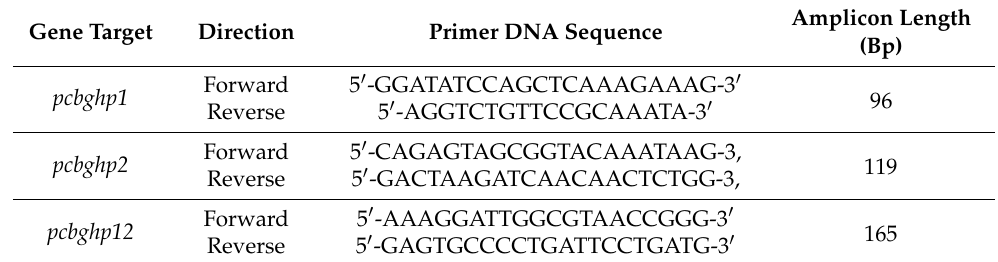
Table 1. Primer sequences for qPCR analysis of P. cryoconitis